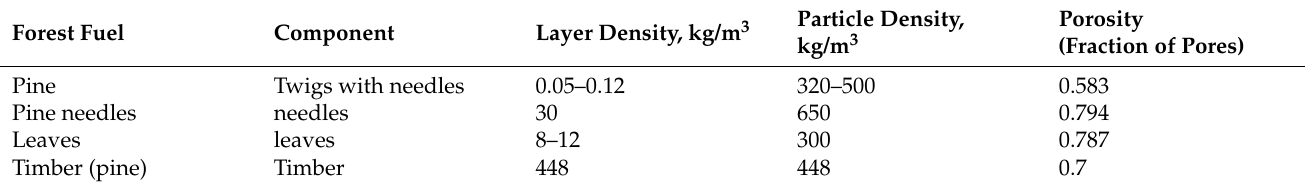
Table 1. Forest fuel